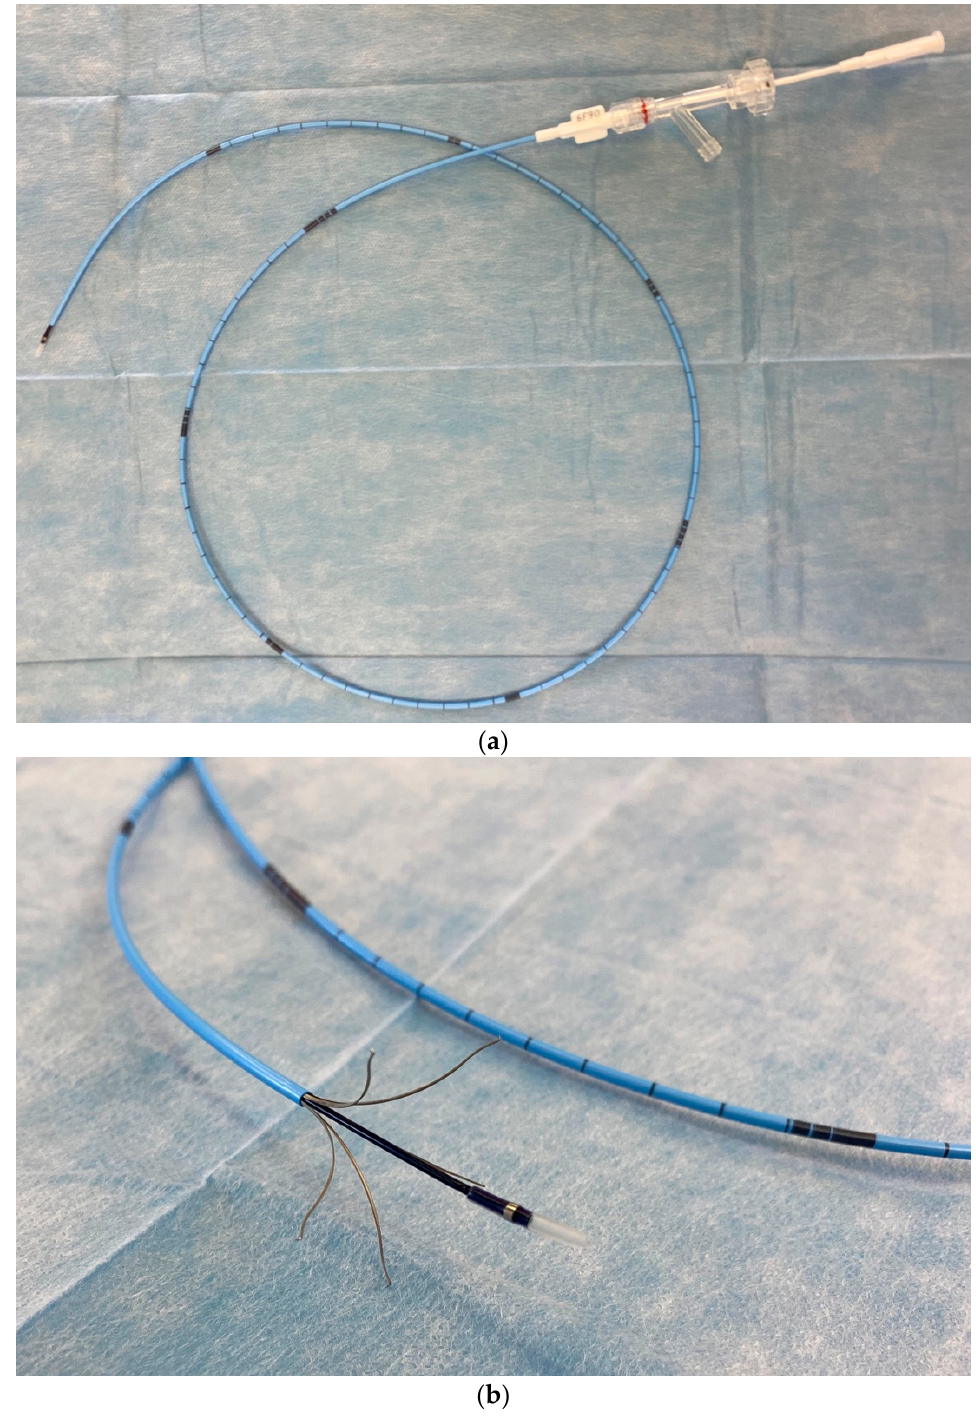
Figure 1. ( a ) Flebogrif catheter construction details—neutral phase. ( b ) Flebogrif catheter construction details—active phase.